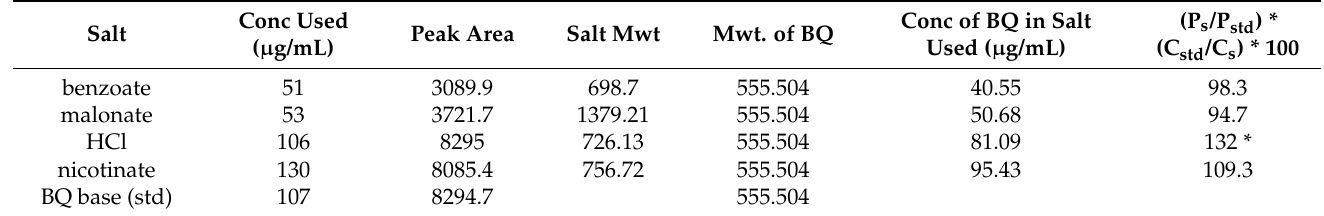
Table 2. Purity determination results for bedaquiline salts using HPLC analysis.